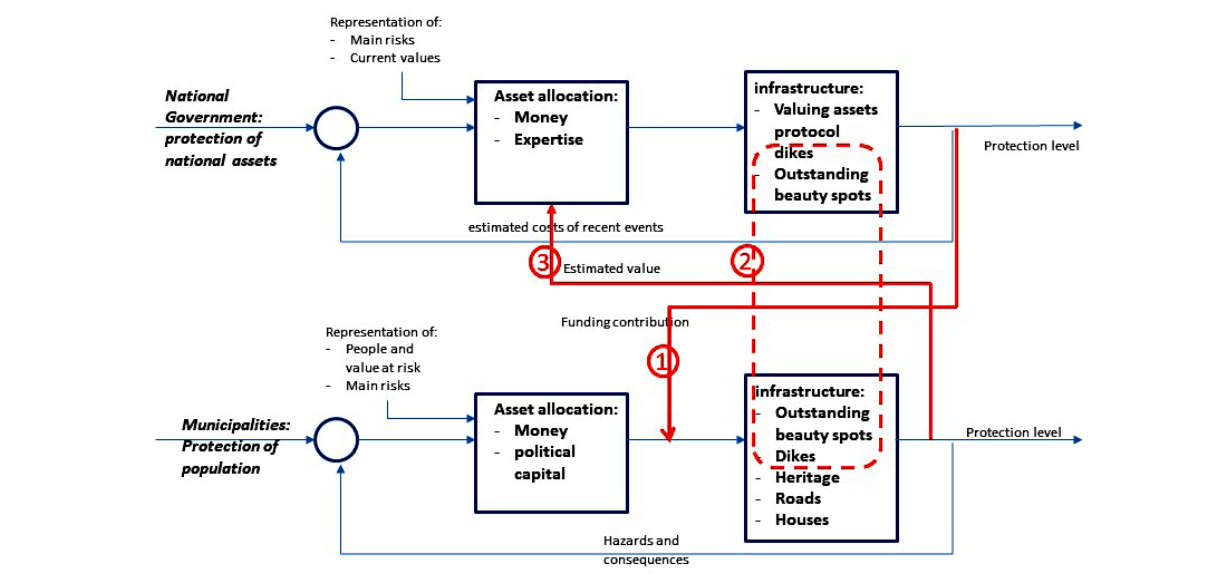
Fig. 3 . Vulnerability transfers observed in the UK’s flood protection